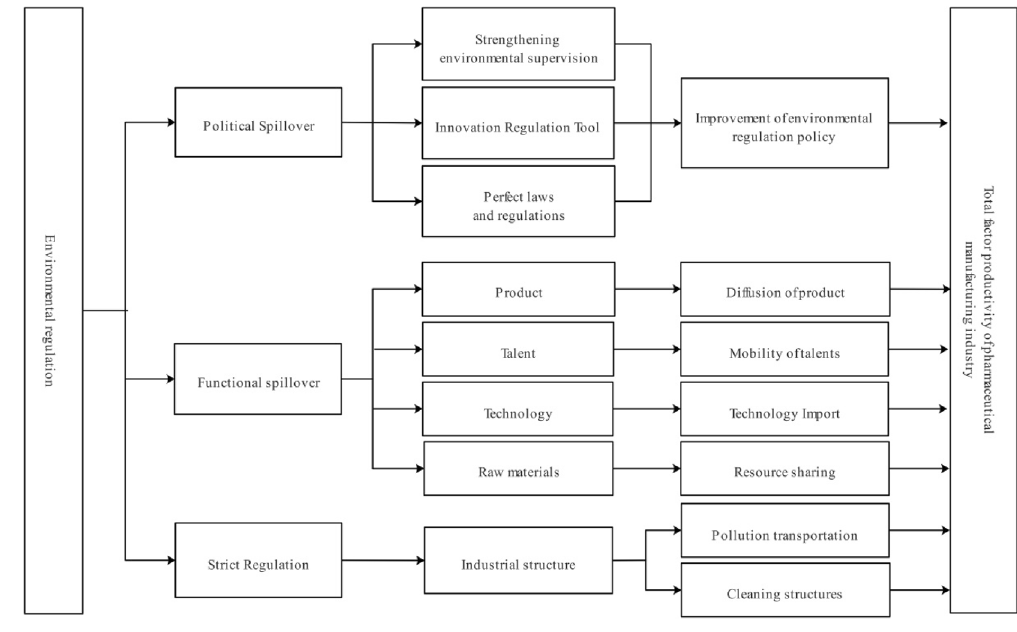
Figure 3. The indirect impact of ER on